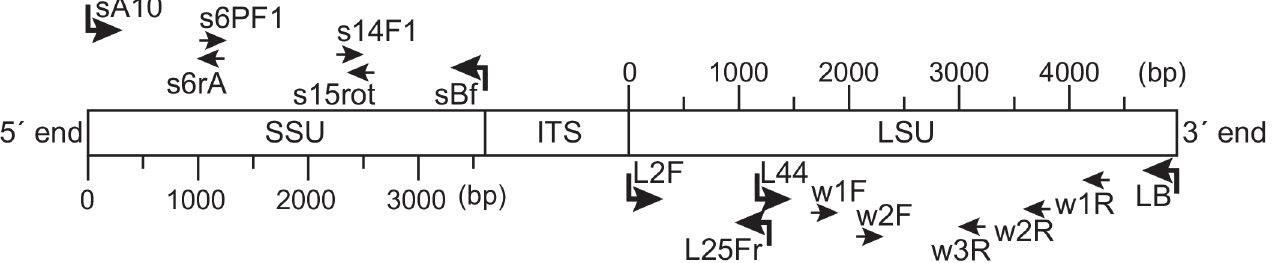
Fig 2. Location of the primers used to amplify and sequence the SSU rDNA and LSU rDNA. The names and orientations of the primers correspond to Table 1. The primers used for PCR amplification are shown by key